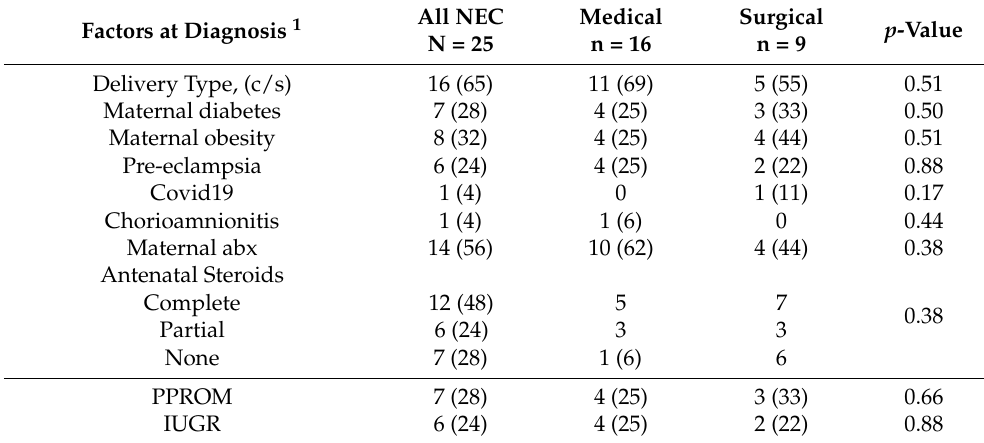
Table 2. Maternal and peripartum factors.